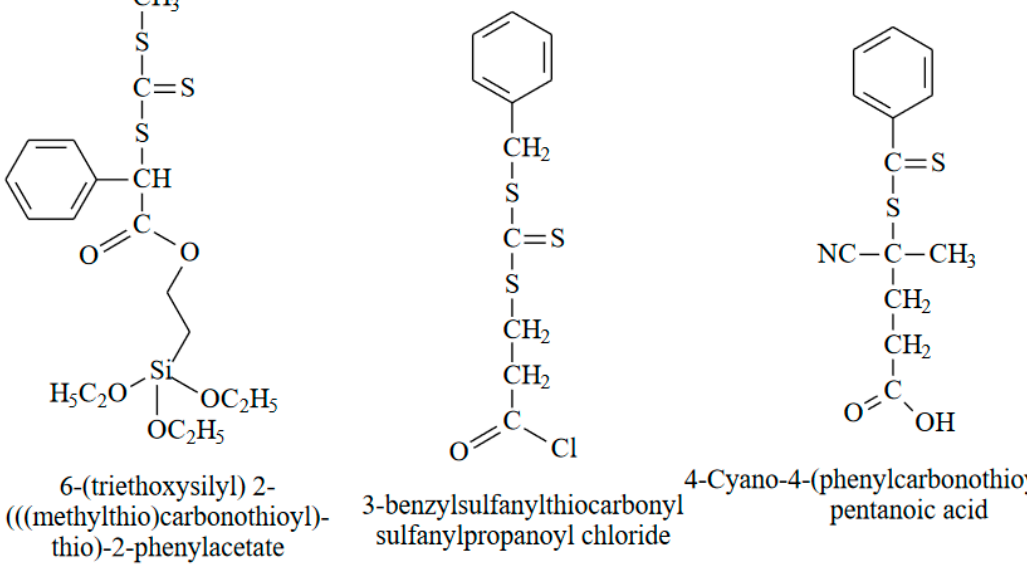
Figure 6. The most common multifunctional initiators for SI-RAFT.